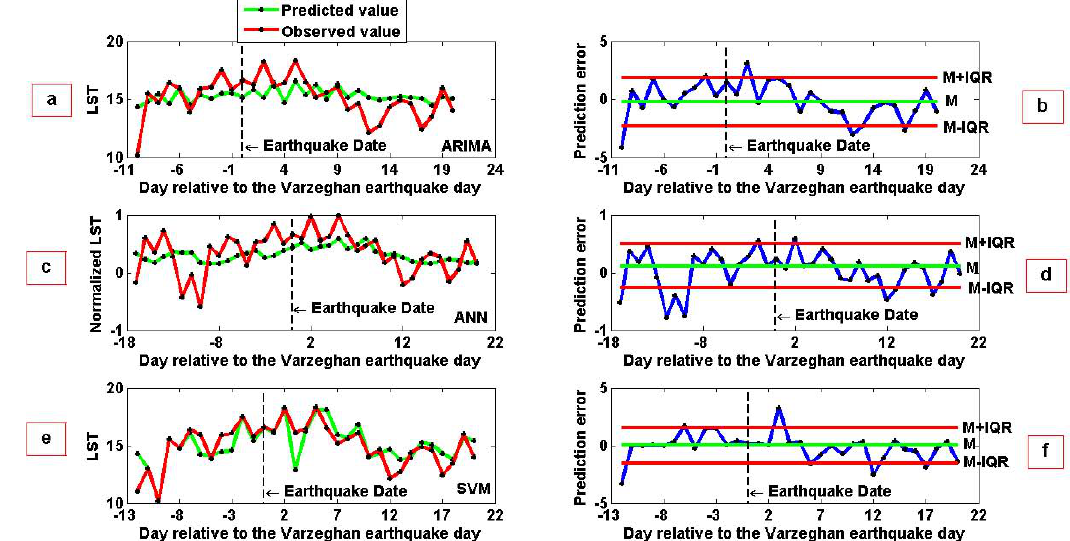
Fig. 4. (a) , (c) and (e) represent the variations of the observed (red line with open squares) and the predicted (green line with open squares) LST values obtained from ARIMA, ANN and SVM methods, respectively, during days selected as testing set. (b) , (d) and (f) represent the variations of the differences between the observed and the predicted values of LST obtained from ARIMA, ANN and SVM methods on days selected as testing set. The earthquake day is represented as a vertical dotted line. The red horizontal lines indicate the upper and lower bounds ( M ± IQR ). The green horizontal line indicates the median value ( M ). The x-axis represents the day relative to the earthquake